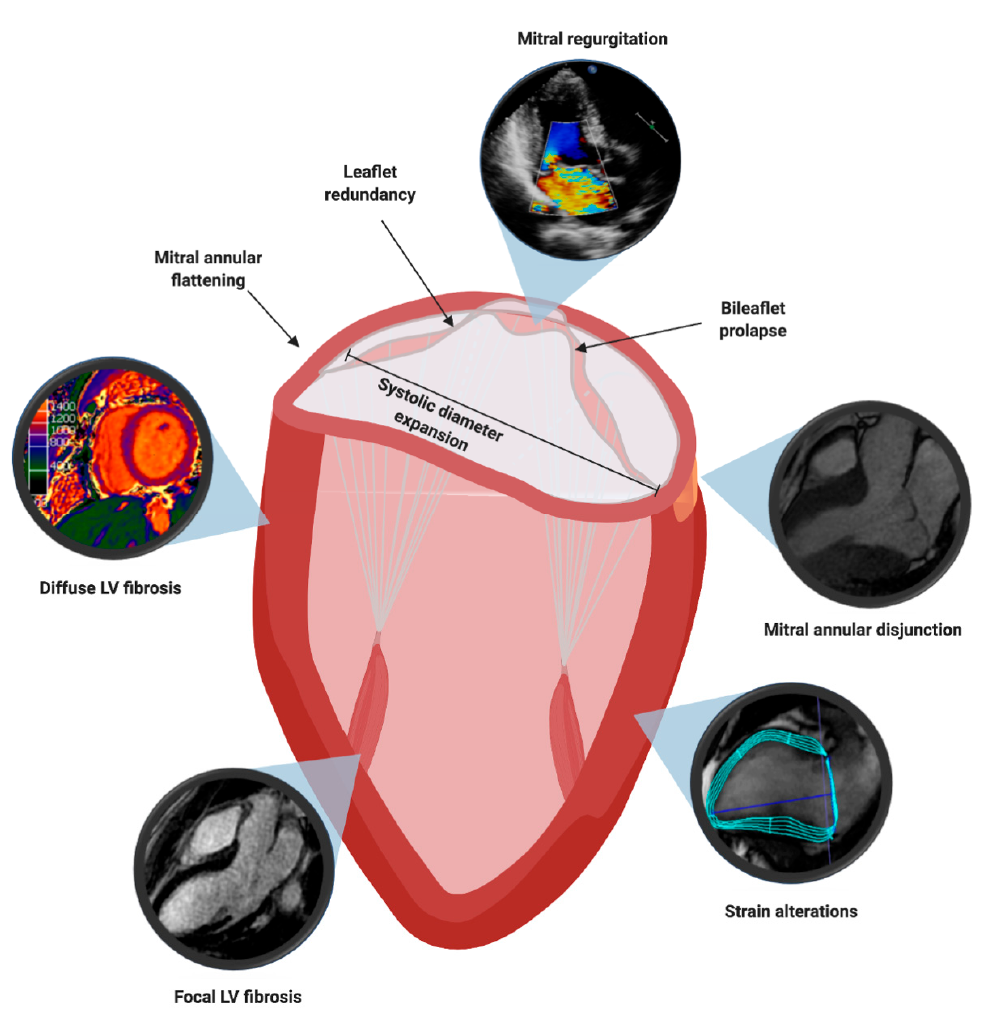
Figure 4. Multimodality Imaging Features Associated to Sudden Cardiac Death in Mitral Valve Pro- lapse.